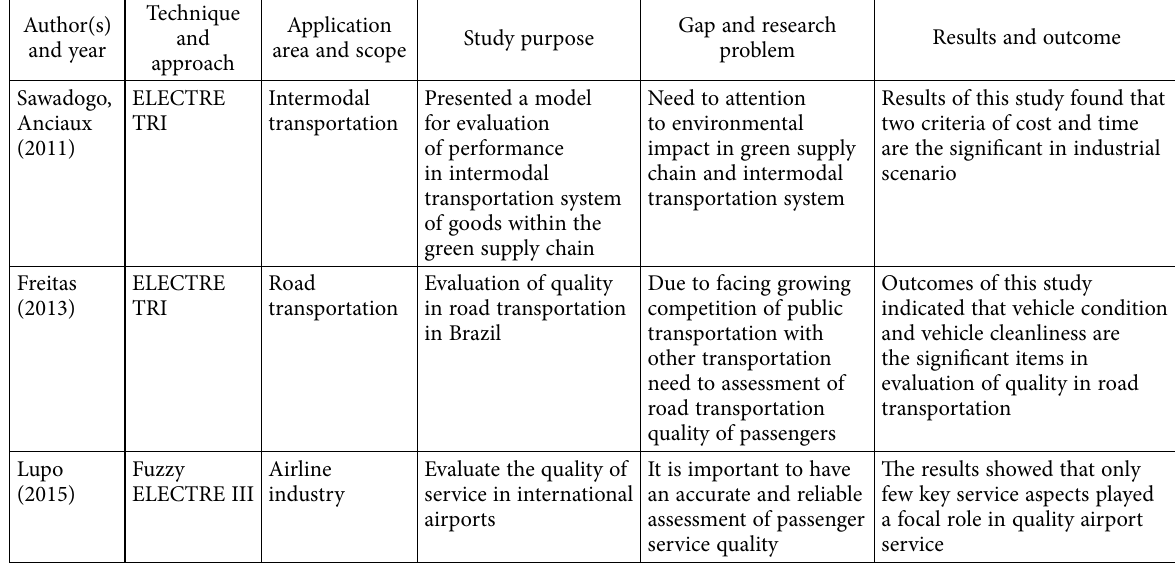
Table 11. Distribution based on ELECTRE and fuzzy